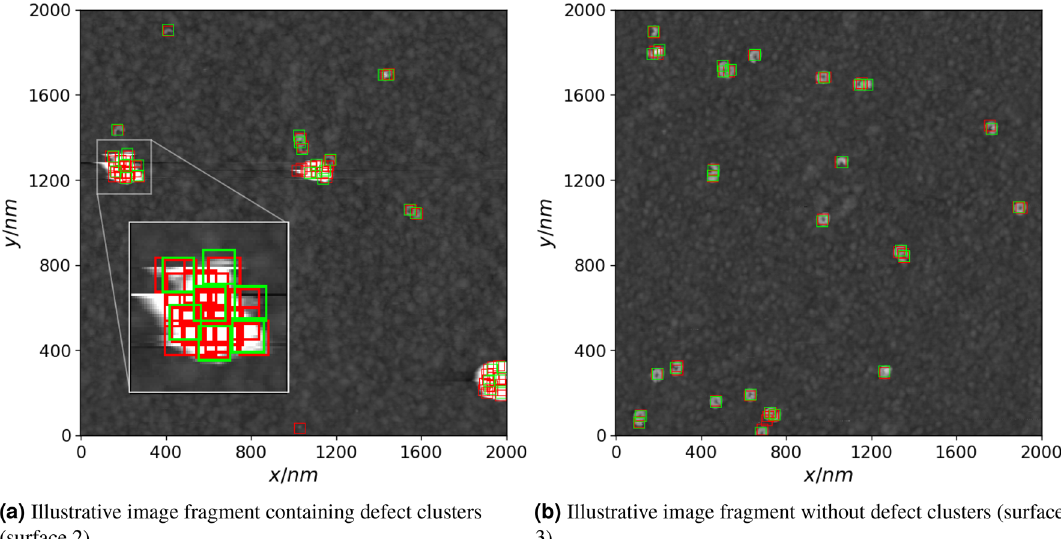
Figure 6. Examples of true defect positions (green rectangles) and predicted (red rectangles) ones by using the convolutional neural network. An instance of a defect cluster and the corresponding true and predicted defect positions is zoomed in on the left image. AFM surface